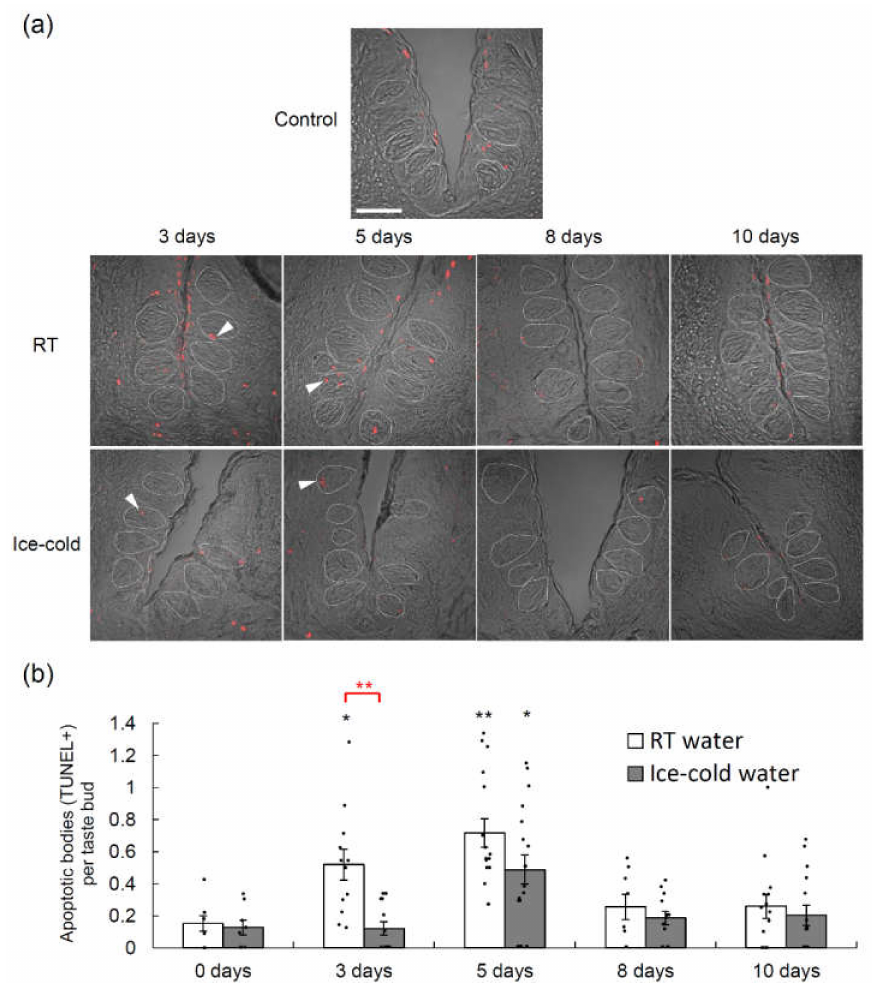
Figure 2. Terminal deoxynucleotidyl transferase-mediated dUTP nick end labeling (TUNEL) assays performedinthecircumvallatepapillaeofmicethatdrankroomtemperature(RT)waterorice-coldwater during the 10-day period following the intraperitoneal administration of TPF (docetaxel, cisplatin and 5-fluorouracil). ( a ) TUNEL signals (red) in the circumvallate papillae of mice that drank RT water or TUNEL-positive apoptotic bodies. Dotted lines outline individual taste buds. Scale bar: 50 µ